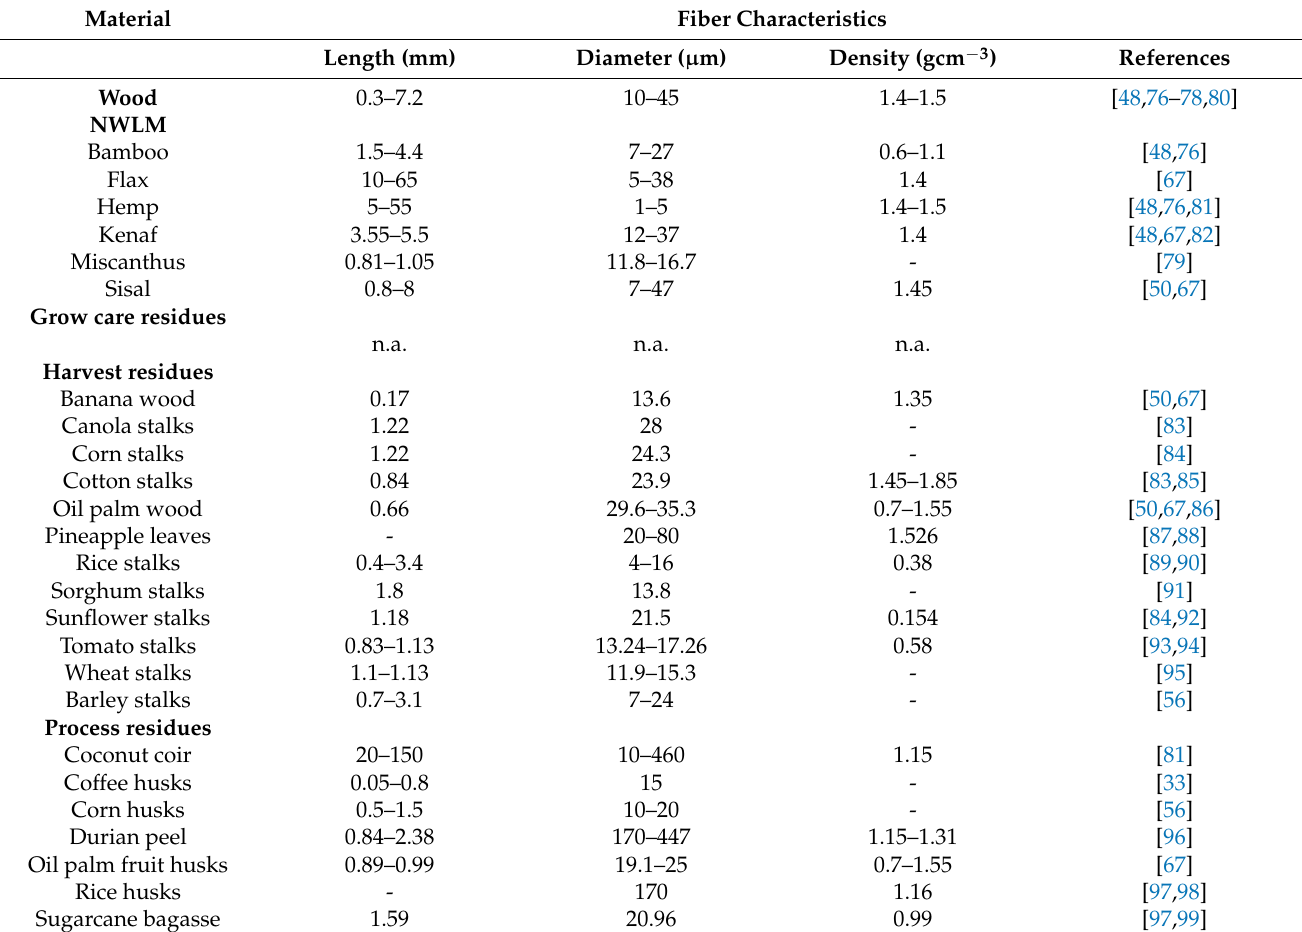
Table 4. Fiber characteristics of alternative materials as compared with wood